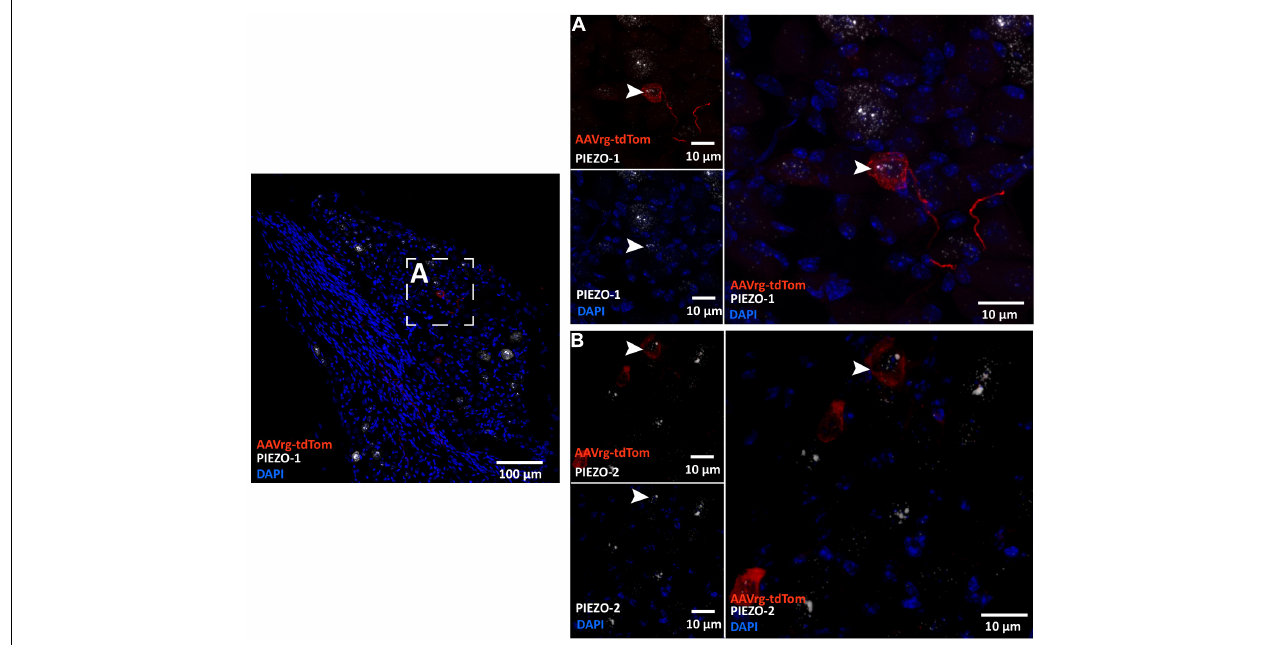
FIGURE 4 | Sensory neurons innervating the aortic arch express the mechanically activated ion channels PIEZO-1 and PIEZO-2. Representative photomicrographs demonstrating the colocalization of the nodose ganglia neurons that expressed tdTom with the mRNAs of (A) PIEZO-1 and (B) and PIEZO-2.